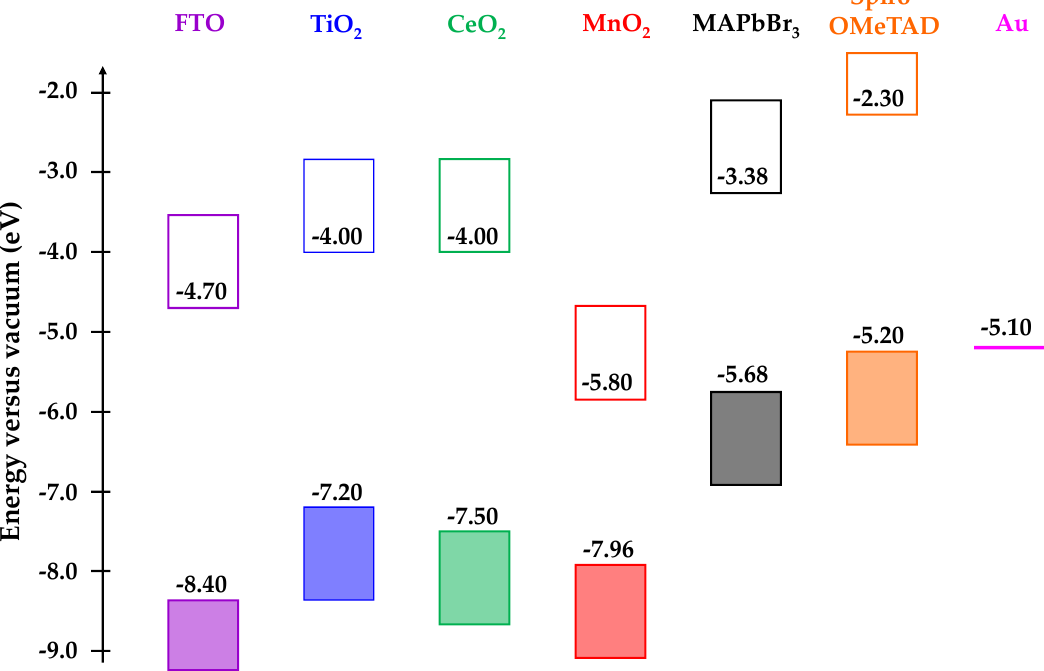
Figure 6. Energy level diagram for TiO 2 , CeO 2 , and MnO 2 metal oxide scaffolds and CH 3 NH 3 PbBr 3 (MAPbBr 3 ) perovskite absorber showing conduction bands (clear boxes) and valence bands (shaded boxes). The spiro-OMeTAD hole transport material (HTM) and electrode materials-fluoride-doped tin oxide (FTO) and gold are shown for clarity.